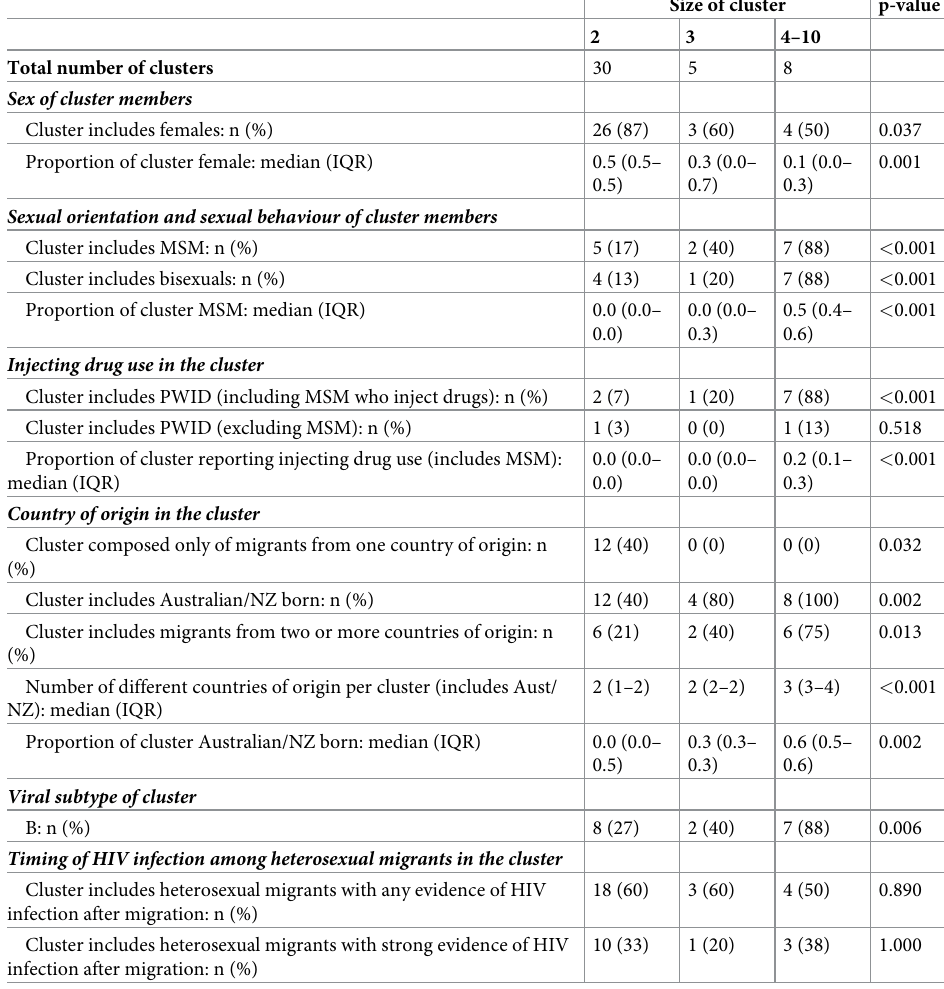
Size of cluster